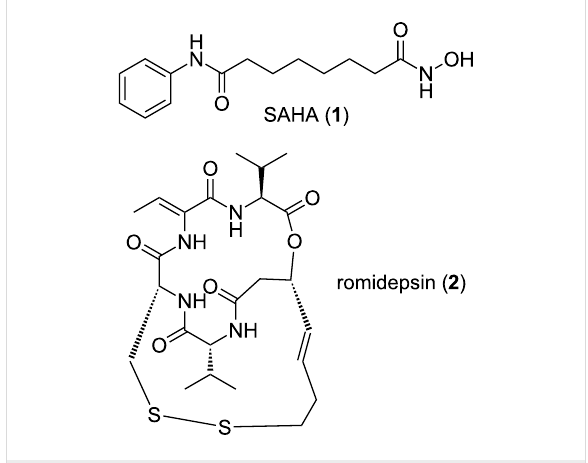
Figure 1: FDA approved HDAC inhibitors for the treatment of